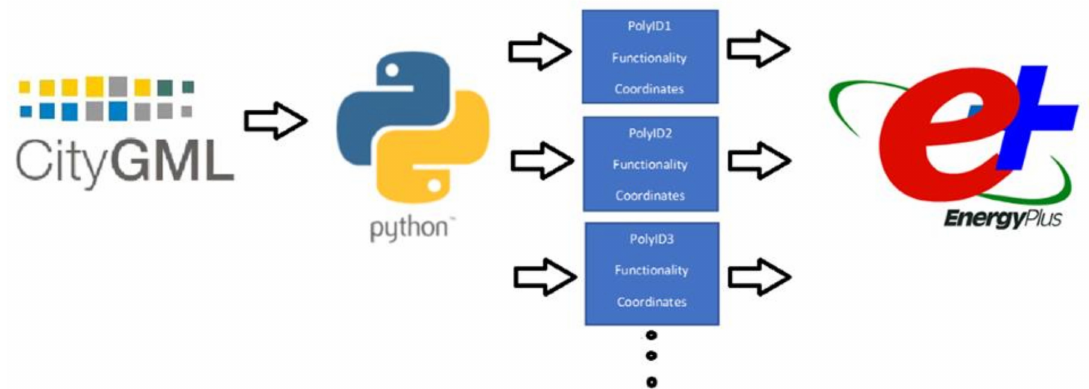
Figure 2. Automatic Urban Building Energy Modeling